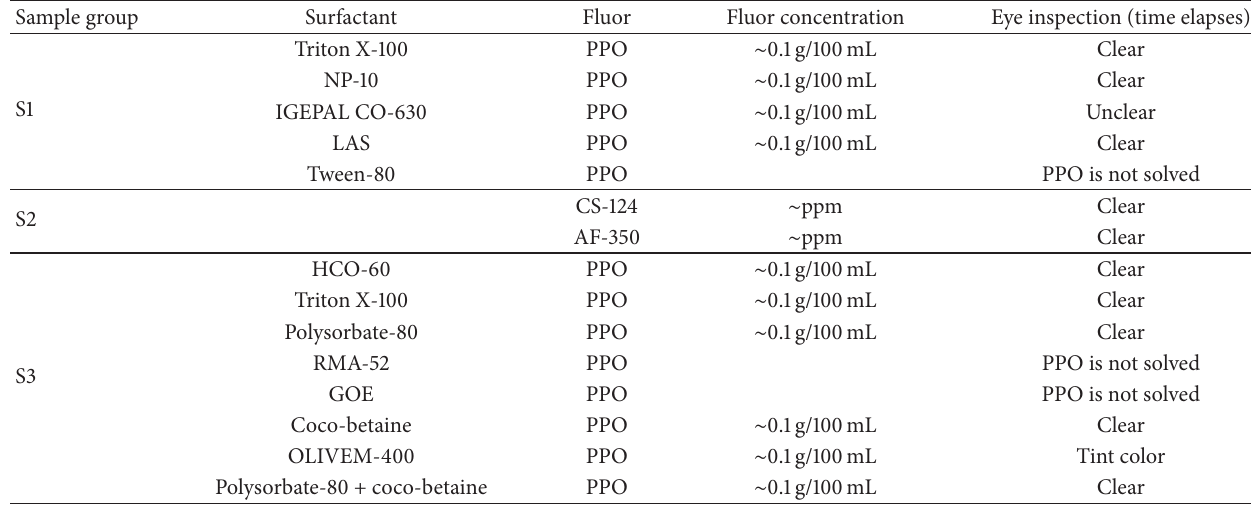
Table 2: Several surfactants used for synthesizing a LS using